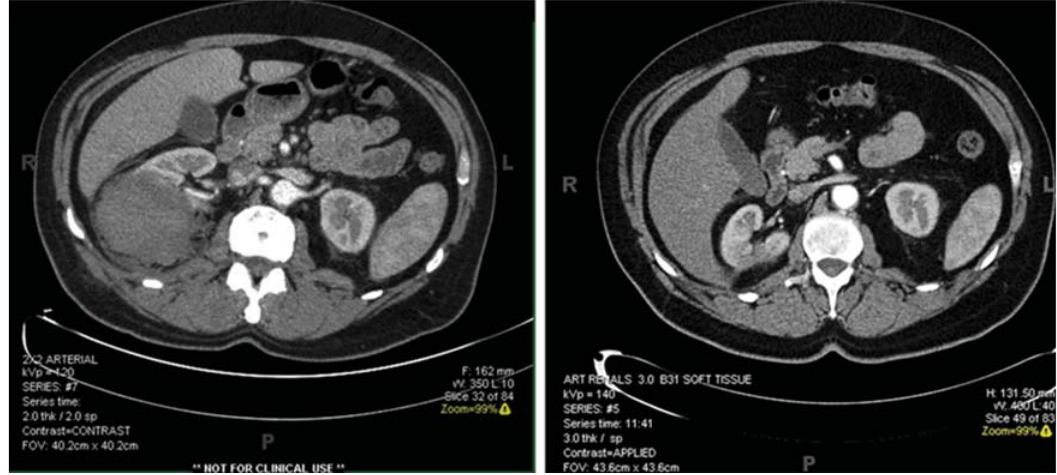
Figure 1 - CT images from a 64 year old patient who failed percutaneous cryotherapy. The patient underwent open salvage partial nephrectomy with no evidence of disease recurrence during 33 months